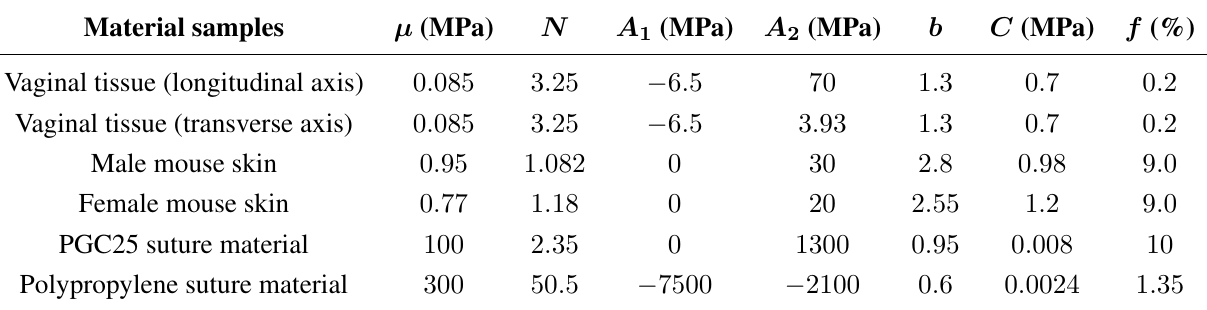
Table 1. Material constants used to fit experimental